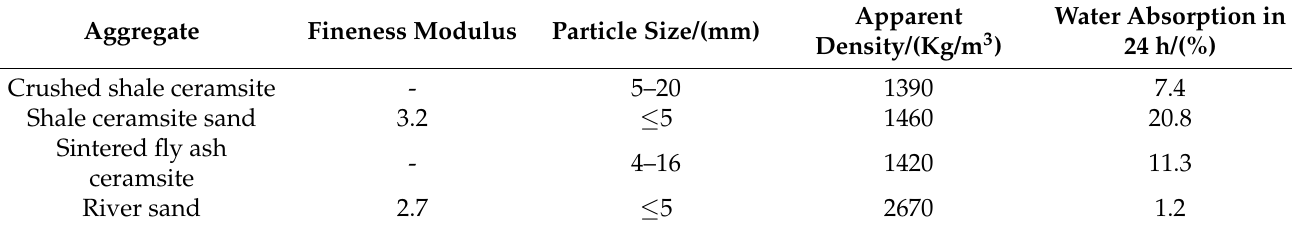
Table 2. Properties of the aggregates used for lightweight concretes (LWCs).